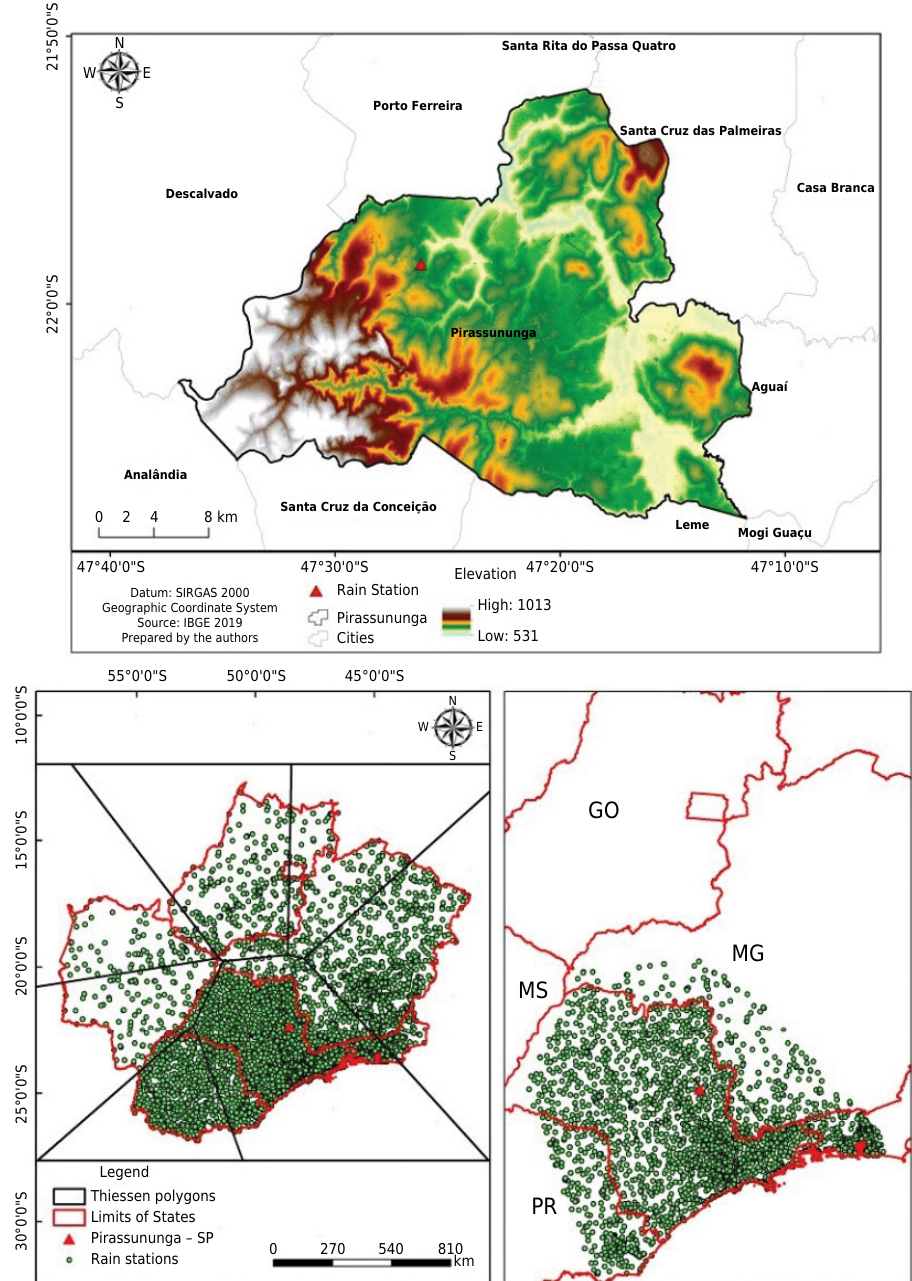
Figure 1. Location of the Meteorological Station at the University of São Paulo, Fernando Costa campus , Pirassununga,